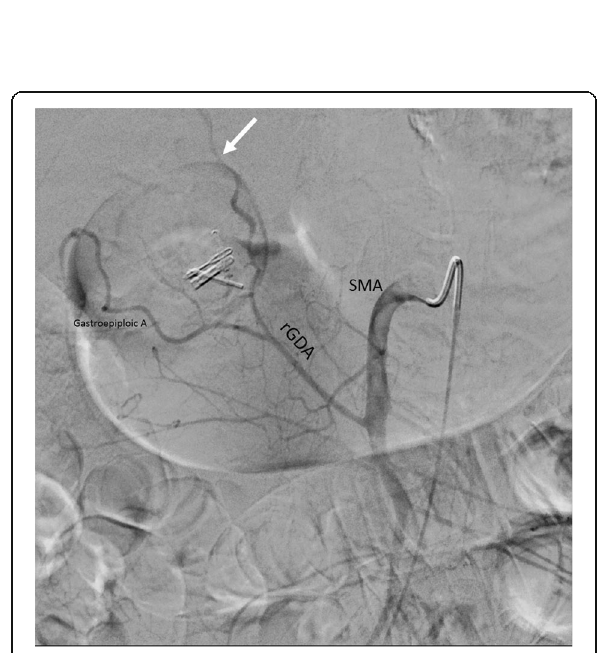
Fig. 2 SMA angiogram demonstrating a replaced GDA (rGDA), which then continued towards the liver